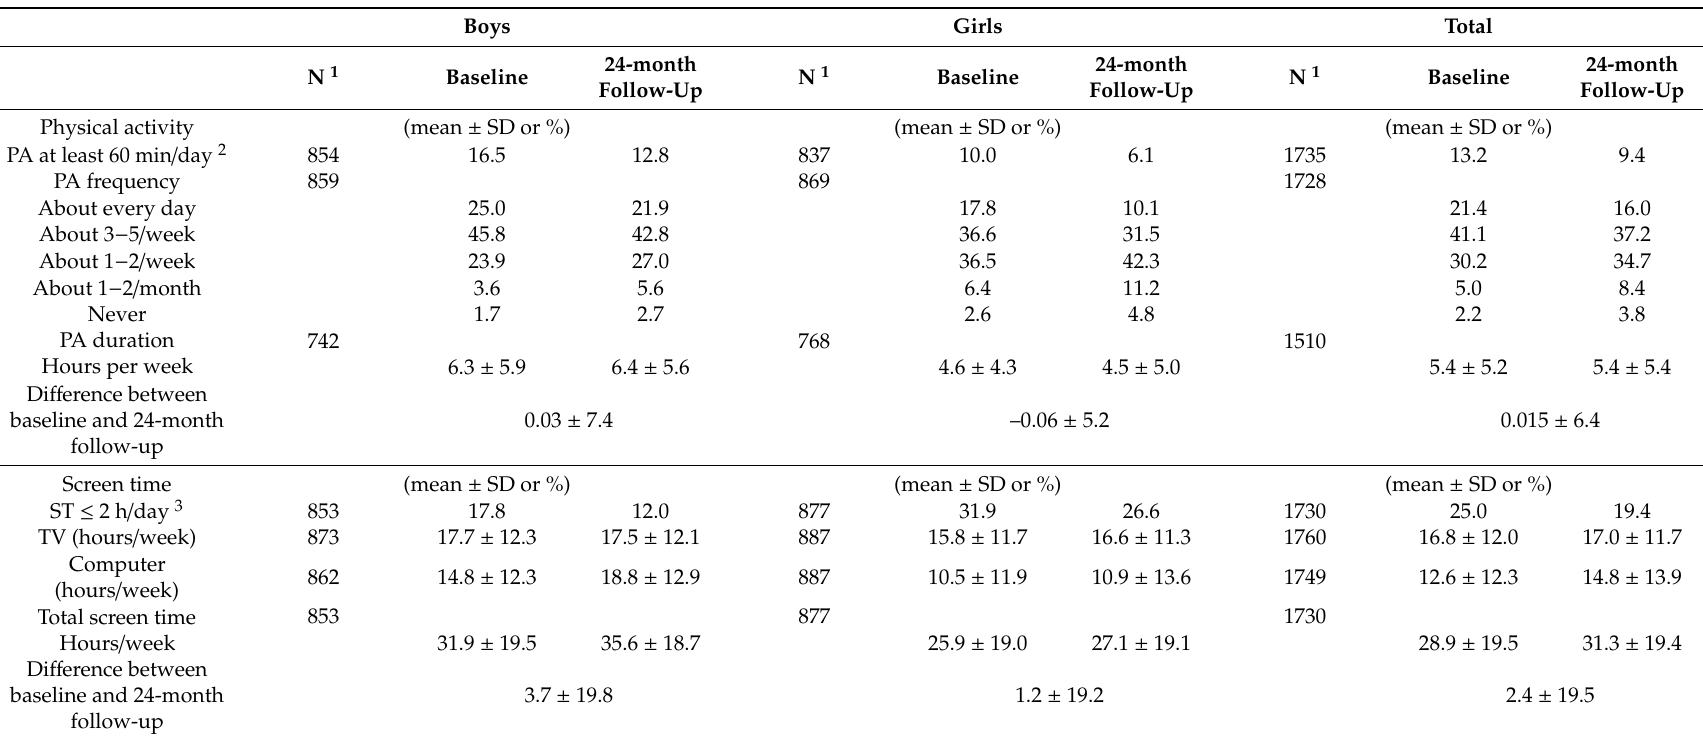
Table 3. Changes over two years in physical activity (PA) and screen time (ST) behaviour among 7th grade to 9th grade students.